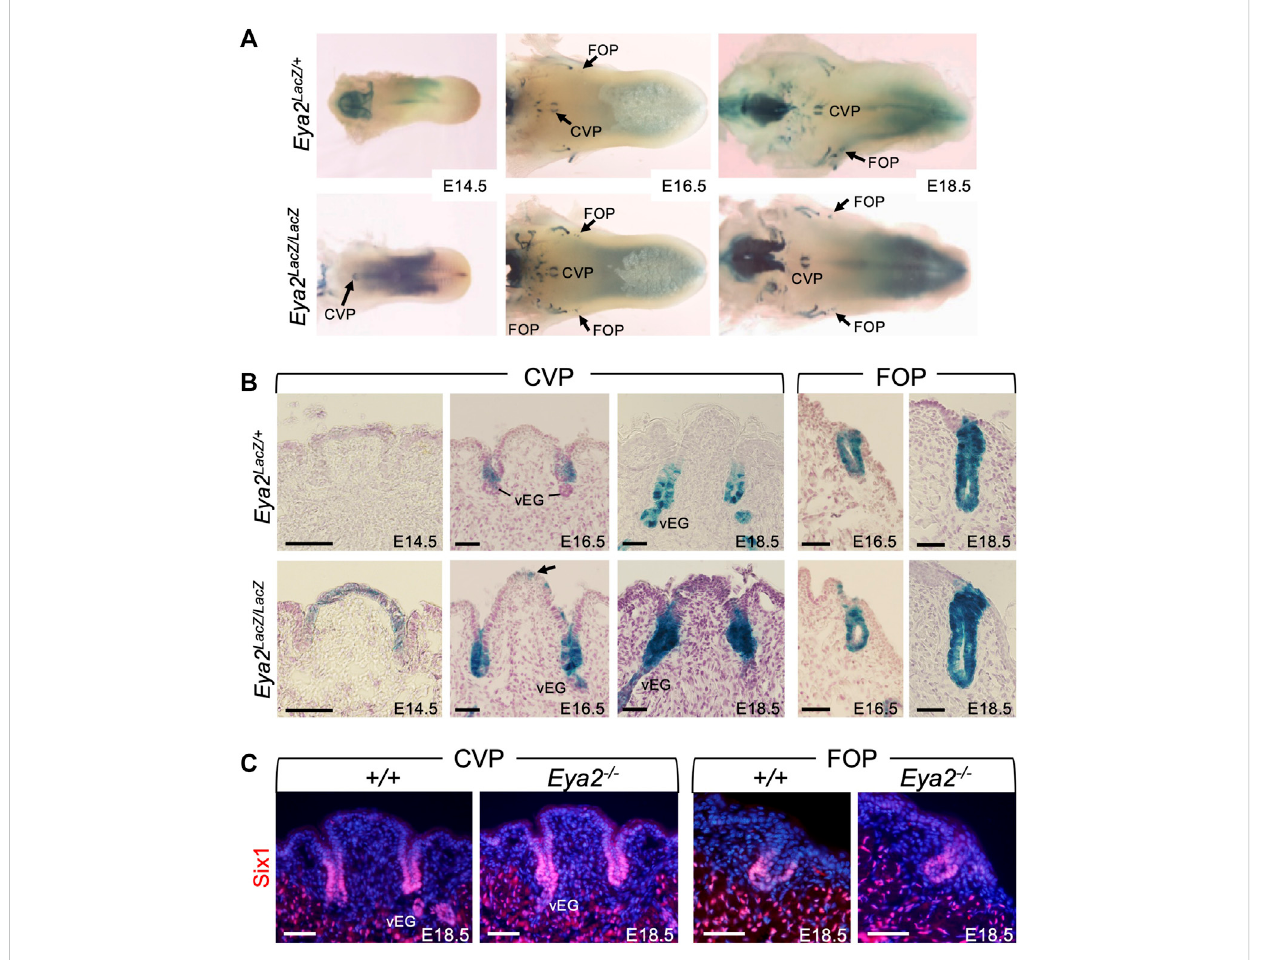
FIGURE 7 Eya2 is expressed in the epithelium of CVP and FOP from the onset of papilla morphogenesis. (A) Whole-mount X-Gal staining of tongues from Eya2 LacZ/+ and Eya2 LacZ/LaZ at E14.5, E16.5, and E18.5. (B) Frontal sections of whole-mount X-Gal stained tongues showing β